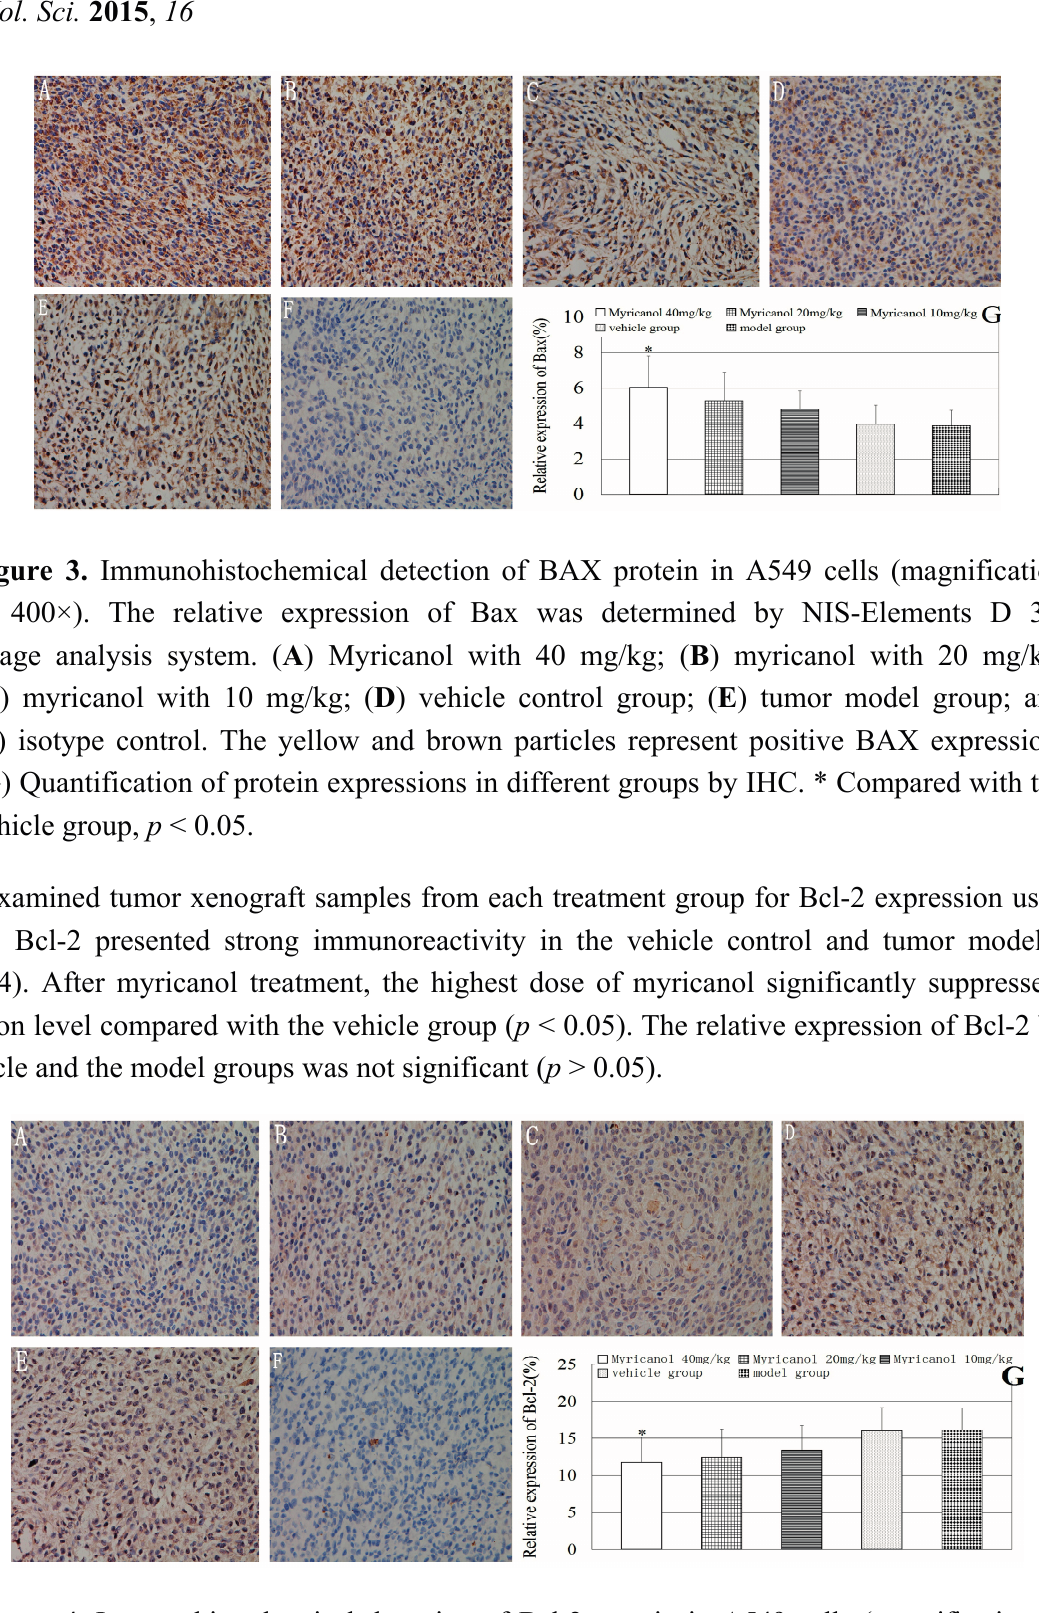
Figure 4. Immunohistochemical detection of Bcl-2 protein in A549 cells (magnification of 400×). The relative expression of Bcl-2 was determined by NIS-Elements D 3.2 image analysis system. ( A ) Myricanol with 40 mg/kg; ( B ) myricanol with 20 mg/kg; ( C ) myricanol with 10 mg/kg; ( D ) vehicle control group; ( E ) tumor model group; and ( F ) isotype control. The yellow and brown particles represent positive Bcl-2 expression; ( G ) Quantification of protein expressions in different groups by IHC. * Compared with the vehicle group, p <